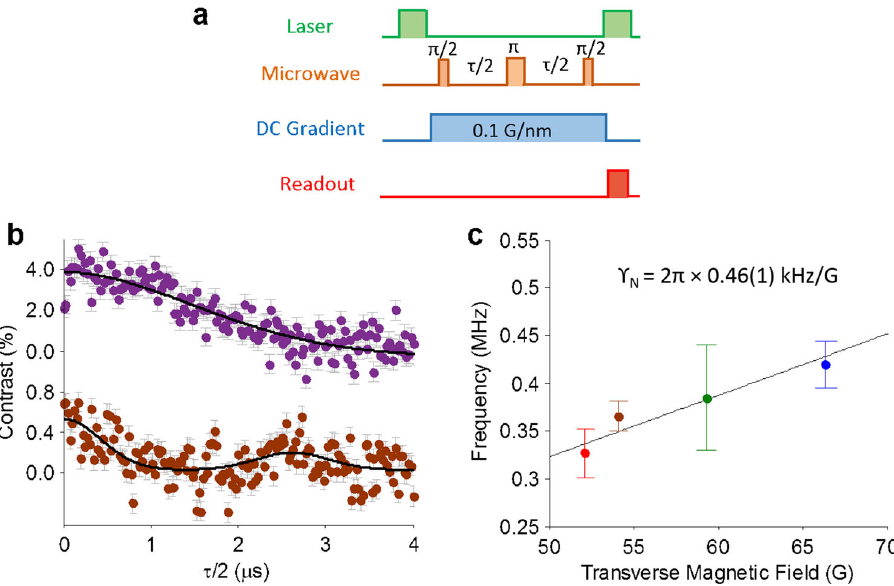
Fig. 4 Site-selective NV NMR spectroscopy. a Site-selective AC magnetometry sequence, consisting of laser initialization and readout pulses, a microwave Hahn echo ( π /2 – π – π /2) pulse sequence with free precession time τ , and a DC fi eld gradient (0.1 G nm − 1 ). The microwave frequency is tuned to one of the site-speci fi c NV ESR resonances to be sensitive only to AC magnetic fi elds at the target spin site and with frequency ≈ 1/ τ . b Measured Hahn echo signal as a function of free precession time τ for no applied magnetic fi eld gradient, which probes all four NV sites ( upper panel ), and an applied DC fi eld gradient and the microwave frequency tuned to address only NV site C ( lower panel ). With no applied fi eld gradient, NV spins in all sites experience only the uniform longitudinal bias fi eld B 0, hence the NV Hahn echo signal provides a measure of the NV ensemble T 2 > 2.5 μ s. With an applied gradient, the NV Hahn echo signal is modulated by the Larmor precession of NV- constituent 15 N nuclear spins in the transverse component of the gradient fi eld B ? at the selected NV site. In both cases, the data is well fi t ( black curves ) by a model that includes NV ESR and decoherence, 15 N NMR, and the measurement protocol (see Supplementary Discussion 2). Error bars indicate 68% con fi dence intervals. c Measured 15 N NMR frequency vs. transverse fi eld B ? at the four NV sites. B ? values are determined from COMSOL simulations of the magnetic fi eld gradient, constrained by measured NV ESR frequencies at each NV site. A linear fi t to the data yields a 15 N nuclear gyromagnetic ratio of | γ n /2 π | = 0.46(4) kHz G − 1 , which agrees with the accepted value. 19 Error bars indicate